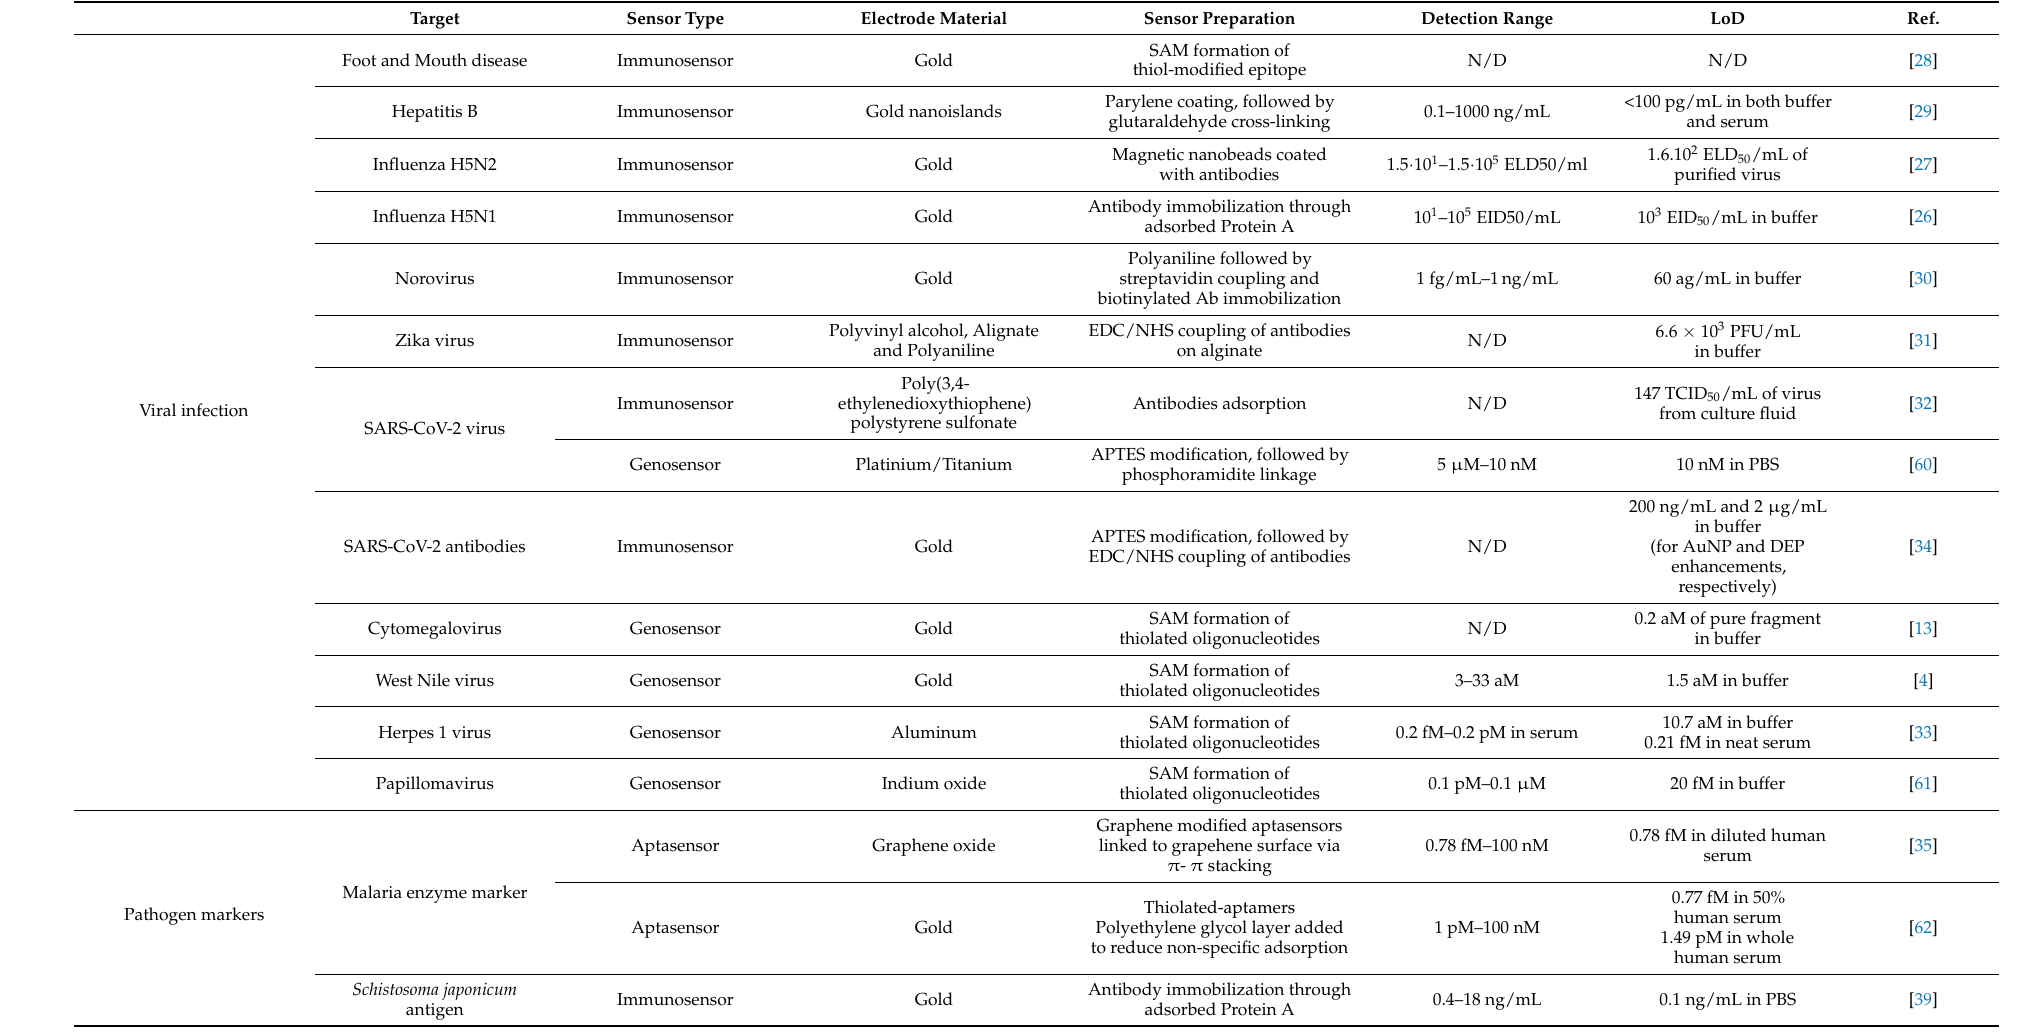
Table 1. Non-faradaic impedimetric biosensors reported for clinical applications. Capacitive sensors for food and waste control were not